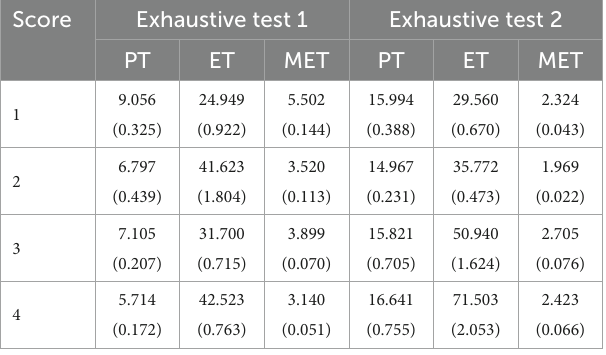
TABLE 6 Means and standard errors of PT , ET , and MET across the score groups of the exhaustive tests 1 and